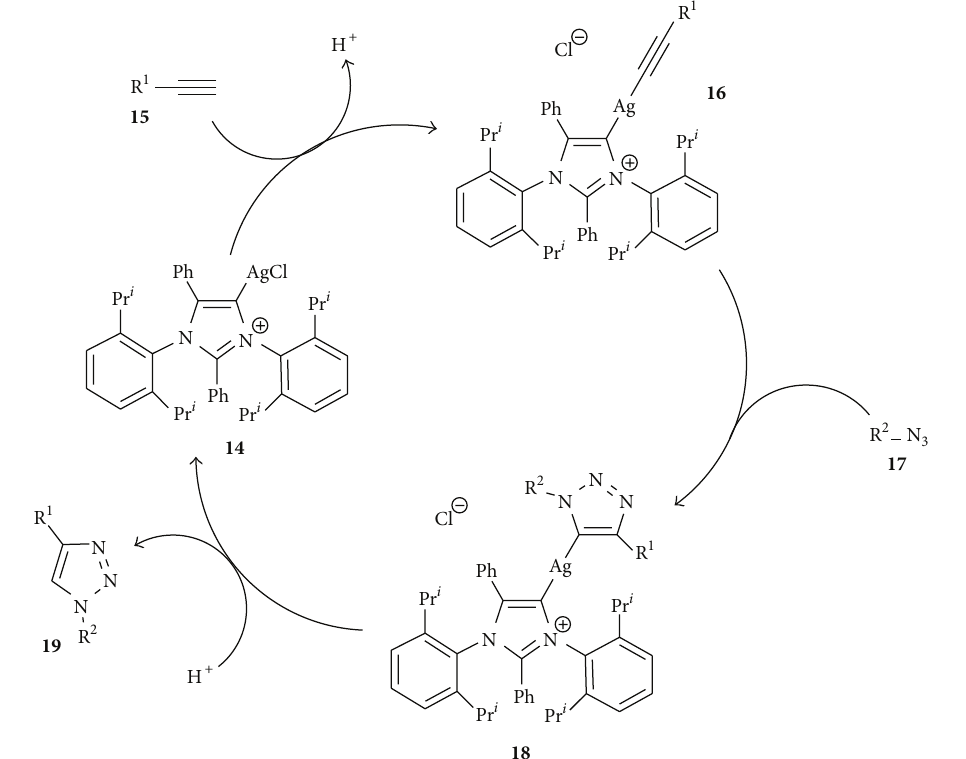
Scheme 3: A plausible reaction mechanism of catalytic